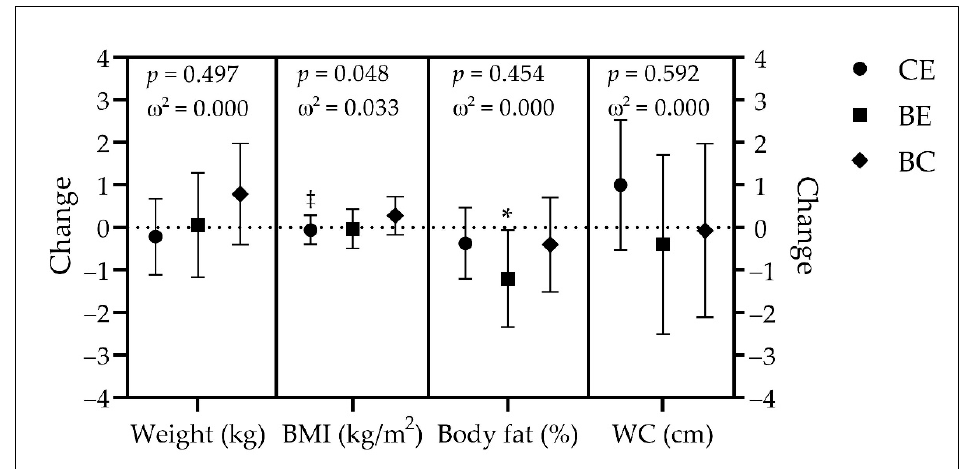
Figure 2. Changes over time in weight, BMI, body fat, and WC. Data expressed as least squares mean and 95% confidence intervals; p -values calculated with one-way ANCOVA for group comparisons (adjusted for age, sex, marital status, income, and employment); omega squared ( ω 2 ) as effect size. ‡ Denotes a significant difference versus BC ( p < 0.05); * denotes a significant change over time ( p < 0.05). BC: Brazilian control group (diamonds); BE: Brazilian experimental group (squares); BMI: body mass index; CE: Canadian experimental group (circles); WC: waist circumference. Participants in CE had no significant changes in weight ( − 0.2 kg, p = 0.638, d = − 0.034),